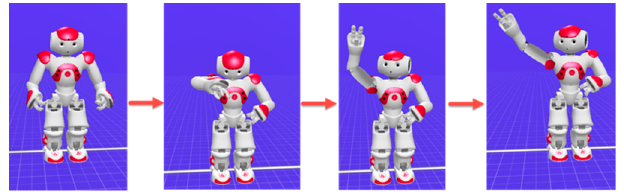
Figure 3. NAO’s hello gesture